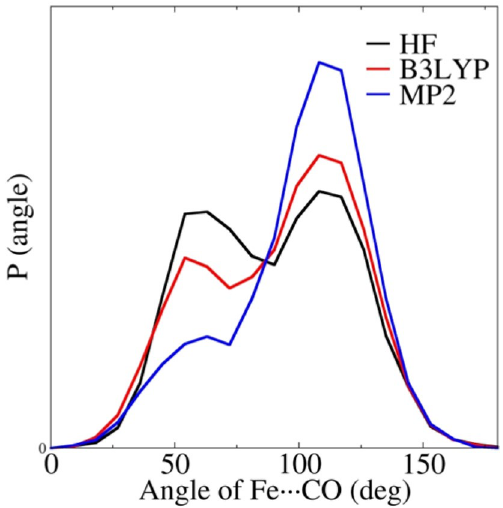
Figure 4. The distribution of the Fe  C ≡ O angle for the QM/MM MD simulations at the HF/aug-cc-pVTZ/ Amberff99SB, B3LYP/aug-cc-pVTZ/Amberff99SB, and MP2/aug-cc-pVTZ/Amberff99SB QM/MM